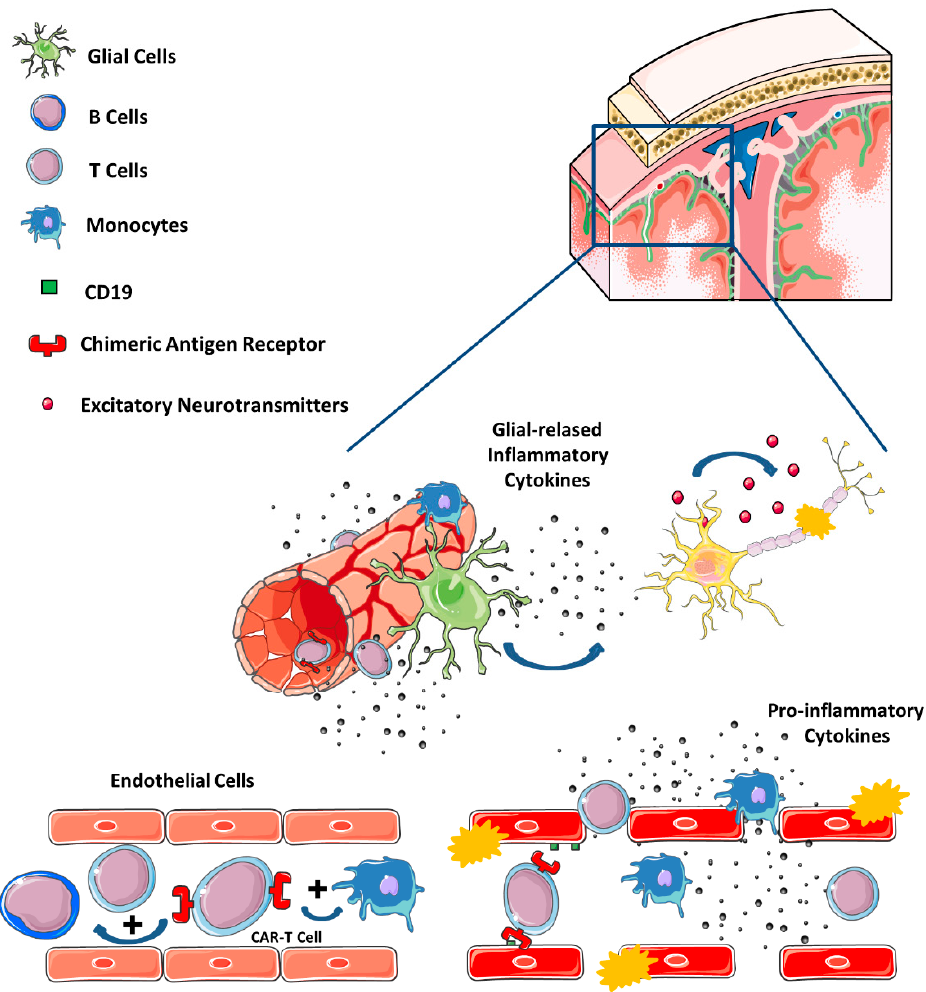
Figure 2. Mechanisms related with CAR-T cells. CAR-T cells induce a proinflammatory secretory phenotype of other blood circulating T and B cells or/and monocytes. This inflammatory state activates the endothelial cells and increase the permeability of the blood-brain barrier. This phenomenon allows the exposition to high concentrations of cytokines and the transmigration of activated immune cells on the cerebrospinal fluid. This inflammatory damage to the endothelial cells and glia enhances production of specific glial cytokines and stimulates the release of excitatory neurotransmitters that can induce excitotoxic damage. In addition, endothelia cells that express CD19 can also be directly damaged by CAR-T cells. Modified from Vilariño et al. 2020 [127].